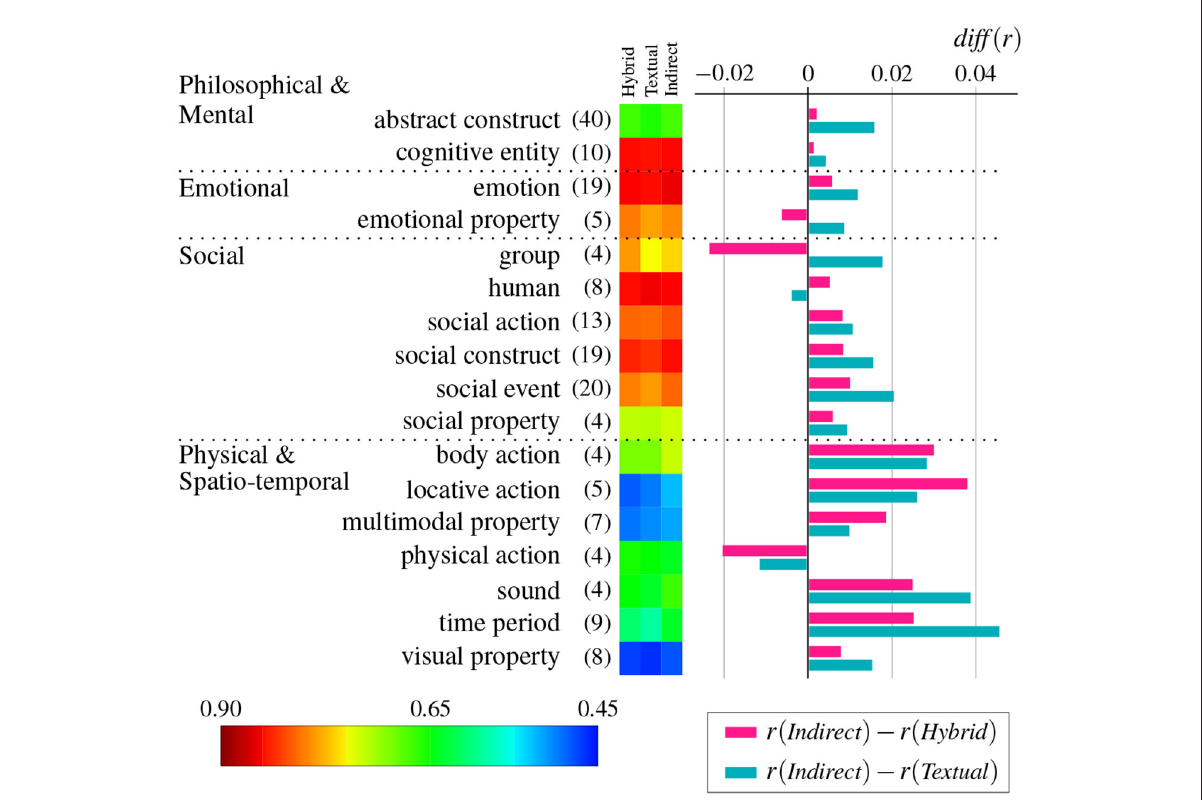
FIGURE6 Mean difference of correlation diff ( r ) between the indirect grounding model and two baseline models averaged per semantic category for abstract words ( θ c = 4.0). The heatmap depicts the mean correlation of hybrid, textual, and indirect grounding models. Numbers in parentheses denote the number of abstract words contained in semantic categories. Red and blue graphs, respectively, denote the degree of improvement against the hybrid model and the textual